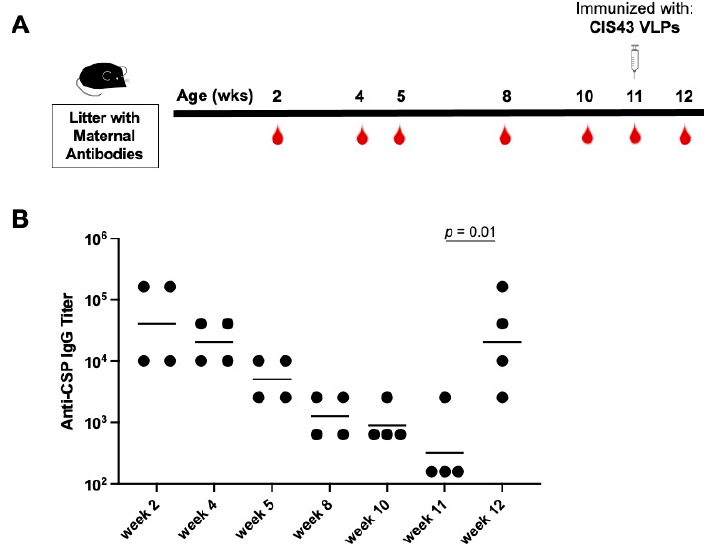
Figure 4. Mice regain responsiveness to CIS43 VLPs as maternal antibody levels wane. ( A ) Experi- mental set-up. Anti-CSP IgG antibody levels were followed in pups born to CIS43 VLP-immunized dams through 11 weeks of age. At 11 weeks, mice were immunized with 5 µg of CIS43 VLPs. ( B ) Anti-CSP IgG endpoint titers at the indicated ages. Each data point represents an individual mouse and lines denote the geometric mean titer of each group. Data were compared statistically by two-tailed t test using log-transformed values. 3.5. Pre-existing Antibodies against the VLP Platform do not Inhibit Anti-CSP Responses in 241 Adult Mice.